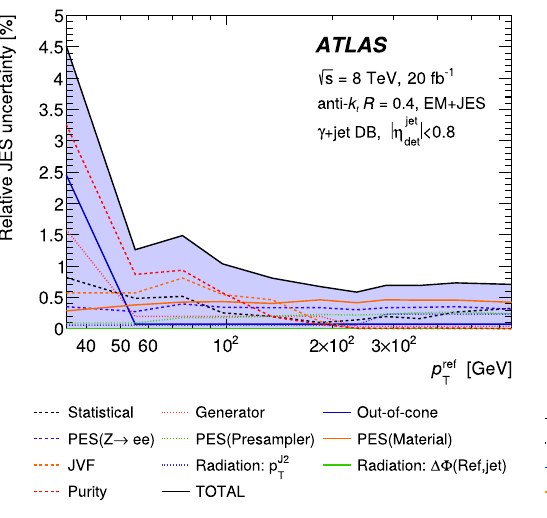
Fig. 26 Summary of the JES statistical and systematic uncertainties evaluated for the Z +jet a DB and b MPF analyses for anti- k t jets with R = 0 . 4 and calibrated with the EM+JES scheme. The total uncertainty, shown as a shaded region, is obtained from the addition